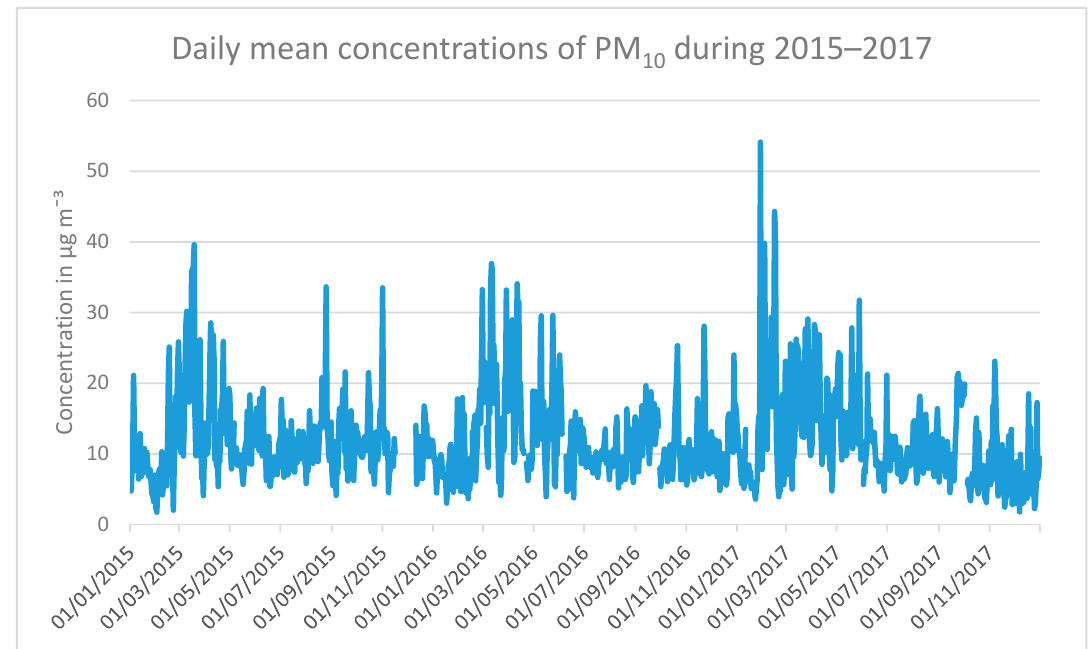
Figure A3. Daily mean concentrations of PM 10 at an urban background station in Stockholm during the period of 2015–2017.